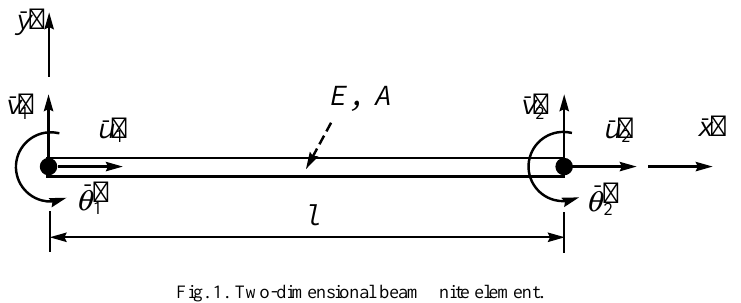
Fig. 1. Two-dimensional beam finite